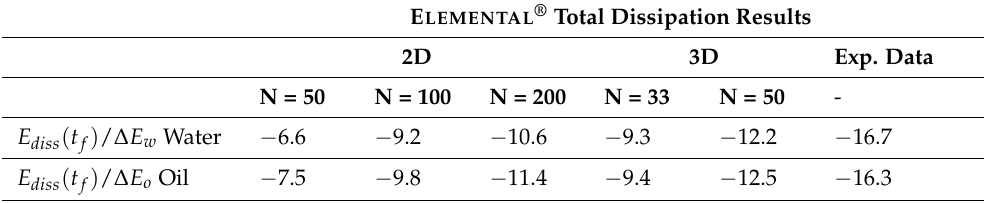
Table 3. Total energy fluid dissipation, E diss ( t f ) for 2D/3D E LEMENTAL ® simulations at spatial reso- lution N = H / ∆ x . Numerical outputs are compared with the experimental data of [4]. The 2D results are ensemble averages of ten different simulations, while 3D results are given by single simulations. E LEMENTAL ® Total Dissipation